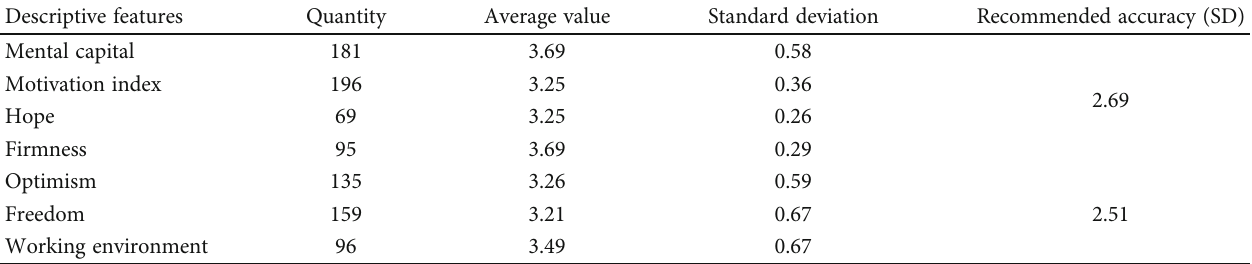
Table 2: Descriptive statistical analysis of psychological capital and its dimensions.